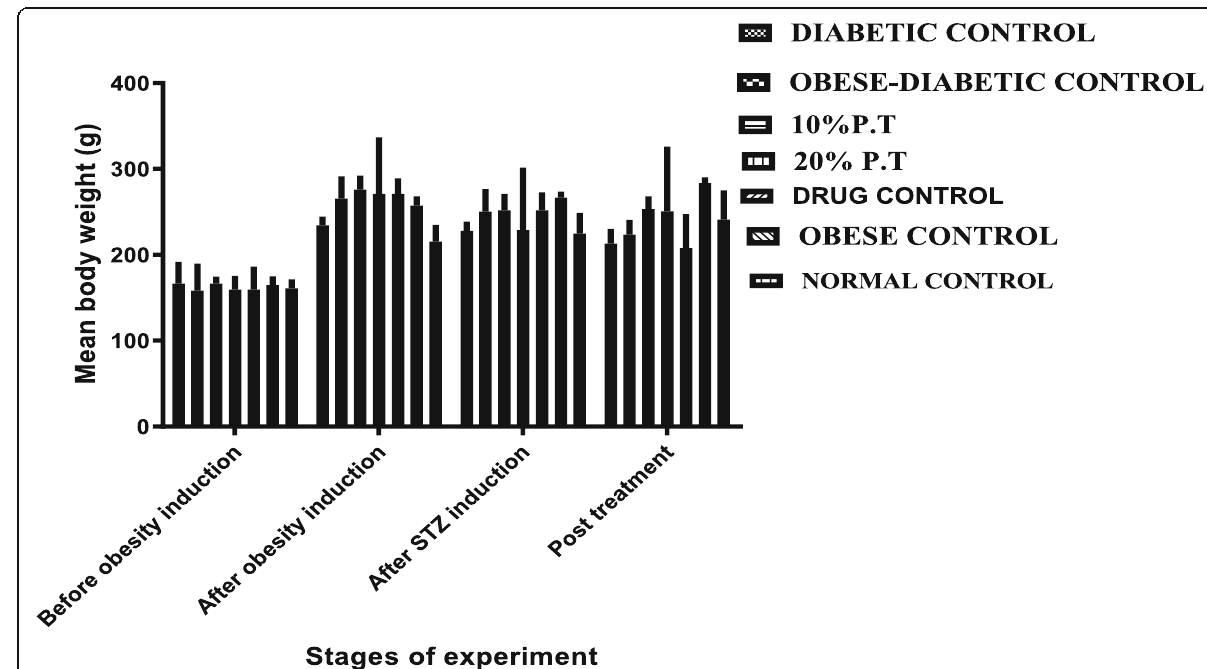
Fig. 1 The mean body weight of the treated and untreated diabetic rats. P. T ( Pleurotus tuber-regium) ,Values are expressed as mean ± SD